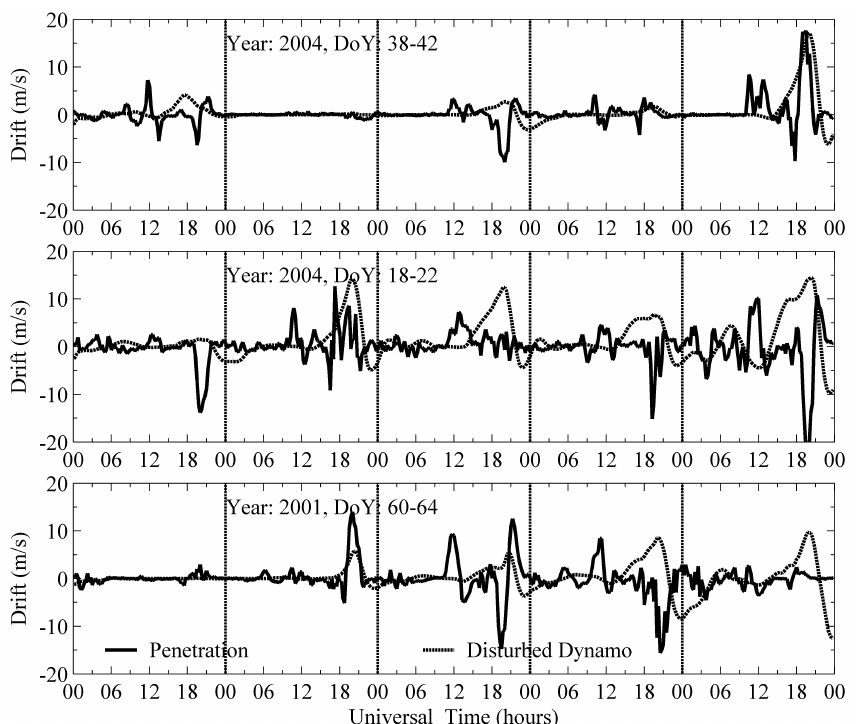
Fig. 7. The prompt penetration vertical drifts and perturbed vertical drift components due to disturbed wind circulation dynamo effects during the periods of those three events. These vertical drifts were predicted by the storm-time drift model of Fejer and Scherliess